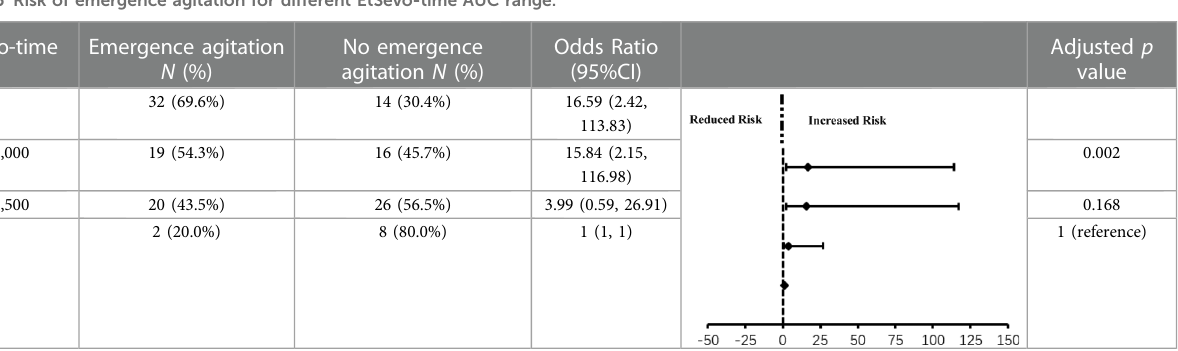
TABLE 5 Risk of emergence agitation for different EtSevo-time AUC